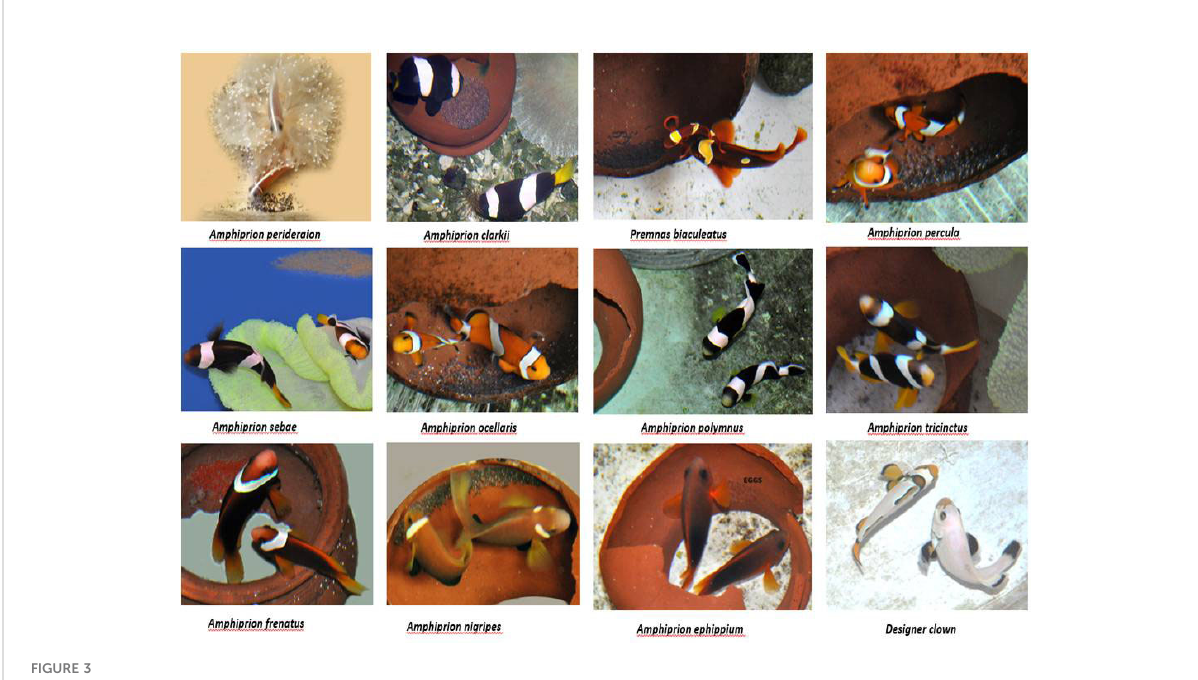
FIGURE 3 Broodstock of clown fi shes with